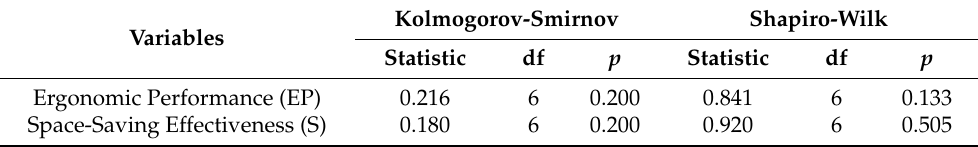
Table 20. Kolmogorov-Smirnov and Shapiro-Wilk tests of normality.